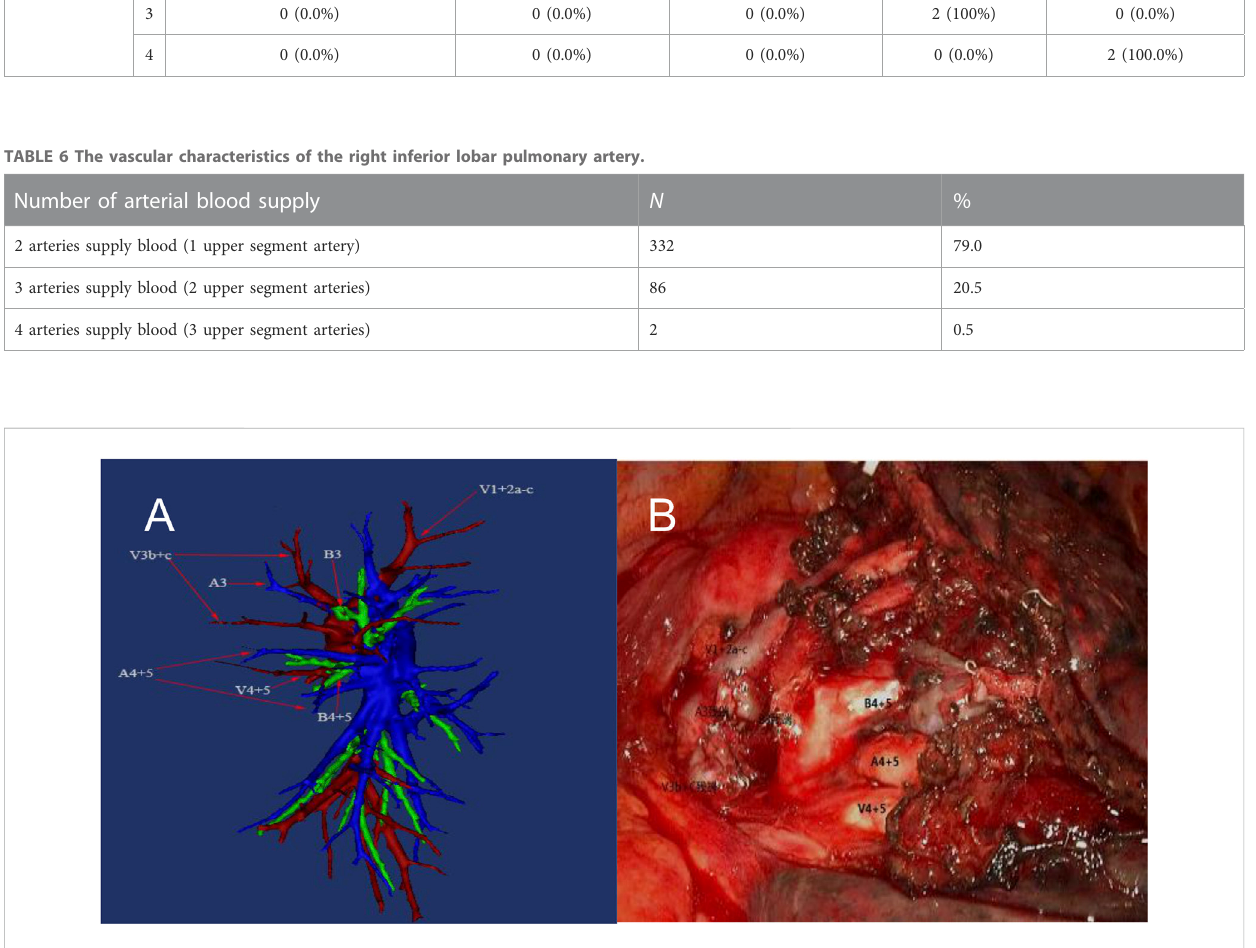
FIGURE 3 Preoperative reconstruction (left) and intraoperative vascular deformation. A3: Anterior segmental artery; A4: Superior lingual segmental artery; A5: Inferior lingual segmental artery; B3: Anterior segmental bronchus; B4: superior lingual segmental bronchus. B5: Inferior lingual segmental bronchus; V1 + V2a – c: Apical segmental vein + Posterior segmental vein and Its branches; V3b + c: Two branches of anterior segmental vein; V4 + V5: Superior lingual segmental vein + Inferior lingual segmental